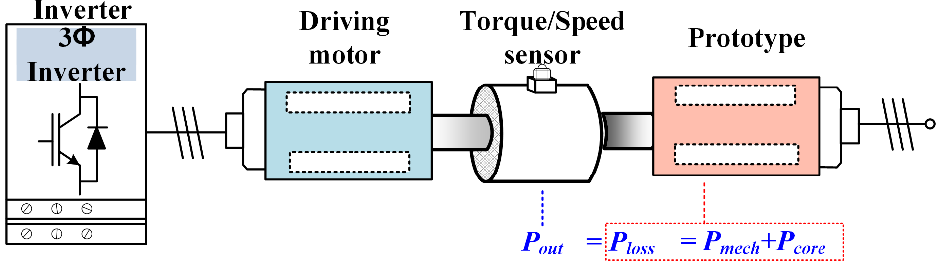
Figure 13. Schematic of performance evaluation system for the no-load test.